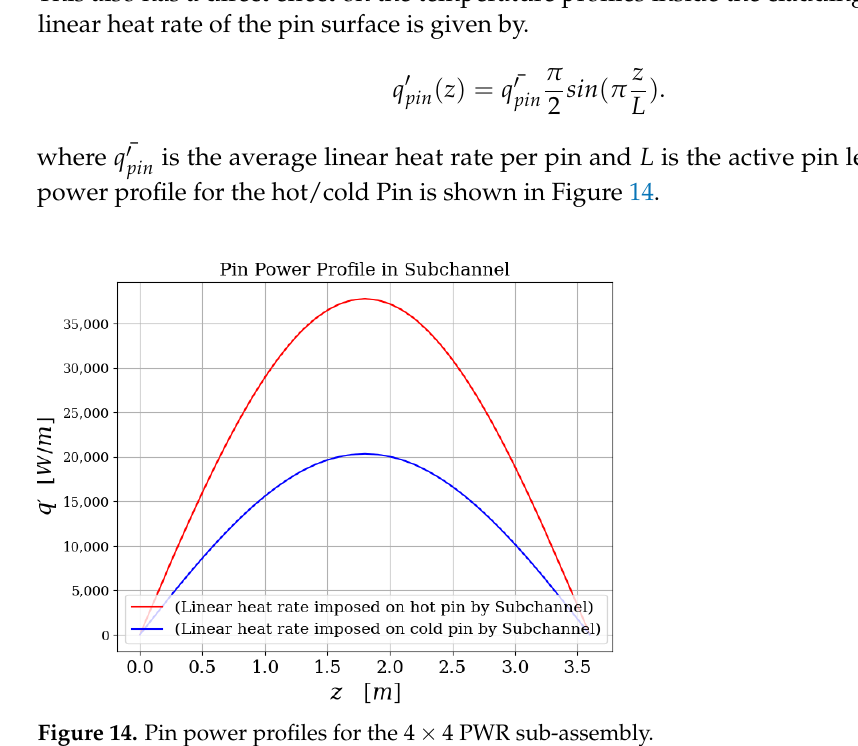
Figure 14. Pin power profiles for the 4 × 4 PWR sub-assembly.